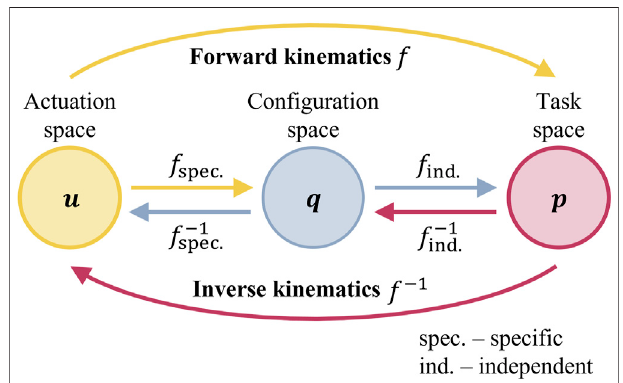
FIGURE 2 | Mapping relationship between the three spaces (i.e., u : actuation space, q : con fi guration space, and p : task space) in soft robot